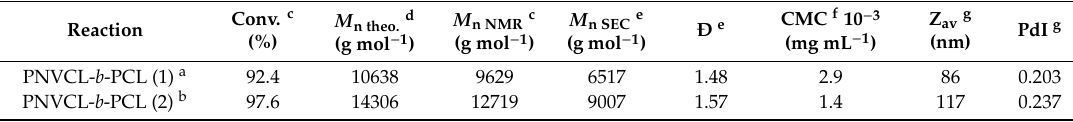
Table 2. Summary of the main characteristics of the PNVCL- b -PCL block copolymers obtained by ROP of ε -CL.